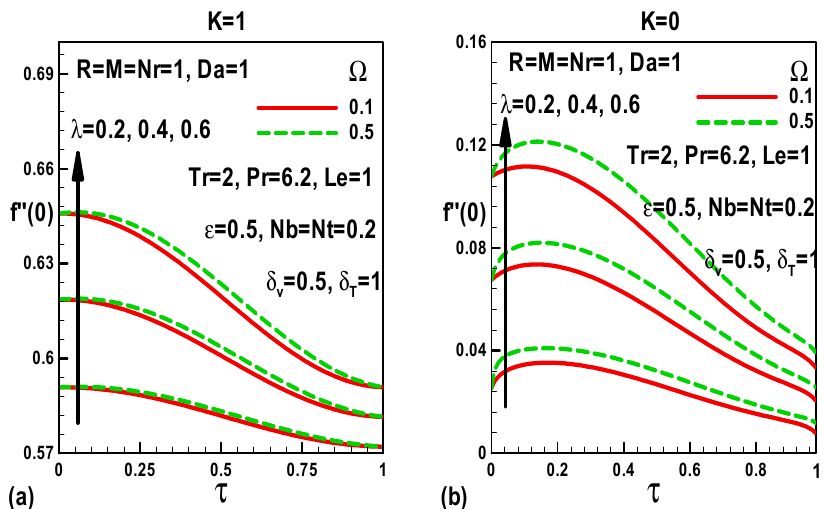
Figure 10. E ff ects of dimensionless time, frequency, and mixed convection parameters on skin friction ( a ) with pressure gradient and ( b ) without pressure